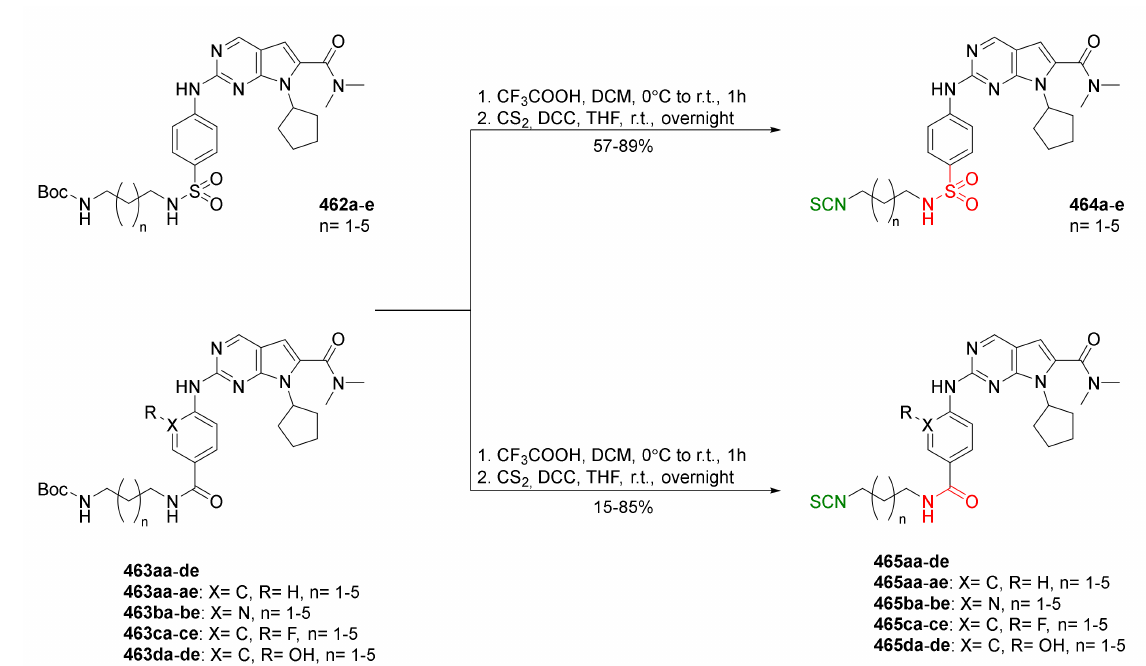
Figure 52. Synthesis of ITCs 464a – e and 465aa – de .